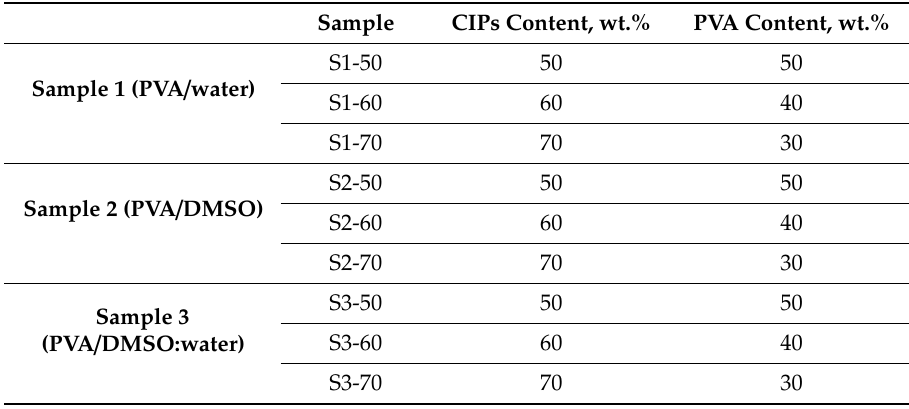
Table 4. The compositions of hydrogel MRP with different types of solvents.